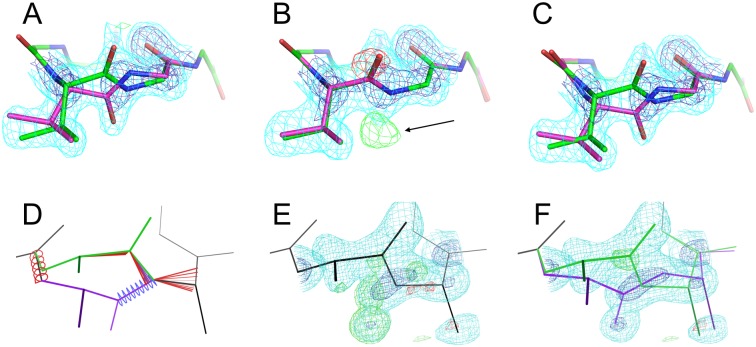
qFit 2.0 successfully identifies known peptide flips.
(A-C) Val539-Gly540 in the Kelch domain of human KLHL7 at 1.63 Å (PDB ID 3ii7). 2mFo-DFc electron density is contoured at 1.2 σ (cyan) and 2.5 σ (blue); mFo-DFc electron density is contoured at +3.0 σ (green) and -3.0 σ (red). (A) The deposited model includes alternative conformations for this peptide, which are well justified by the electron density. (B) qFit 1.0 starting from single-conformer input fails to find the second conformation, resulting in peaks in the difference density map (arrow). (C) qFit 2.0 finds both conformations, resulting in the disappearance of the difference peaks. (D-E) Asn42-Gly43 in carbohydrate binding domain 36 at 0.8 Å resolution (PDB ID 1w0n). The Asn42 sidechain (left, darker green/purple) points up out of the image so is visually truncated. In (E-F), 2mFo-DFc electron density is contoured at 1.5 σ (cyan) and 2.5 σ (blue); mFo-DFc electron density is contoured at +3.0 σ (green) and -3.0 σ (red). (D) The deposited structure includes alternative conformations (green and purple) related by a peptide flip, but re-converges too early at the Gly43 backbone N atom, resulting in >4 σ bond length (red and blue fans) and bond angle (red and blue springs) outliers [34]. (E) qFit 1.0 fails to identify the flip, leaving significant difference density map features. (F) qFit 2.0 identifies the flip at Asn43 and also correctly splits Gly43 into separate conformations, thereby flattening the difference map relative to qFit 1.0 and eliminating the covalent geometry errors in the original structure.